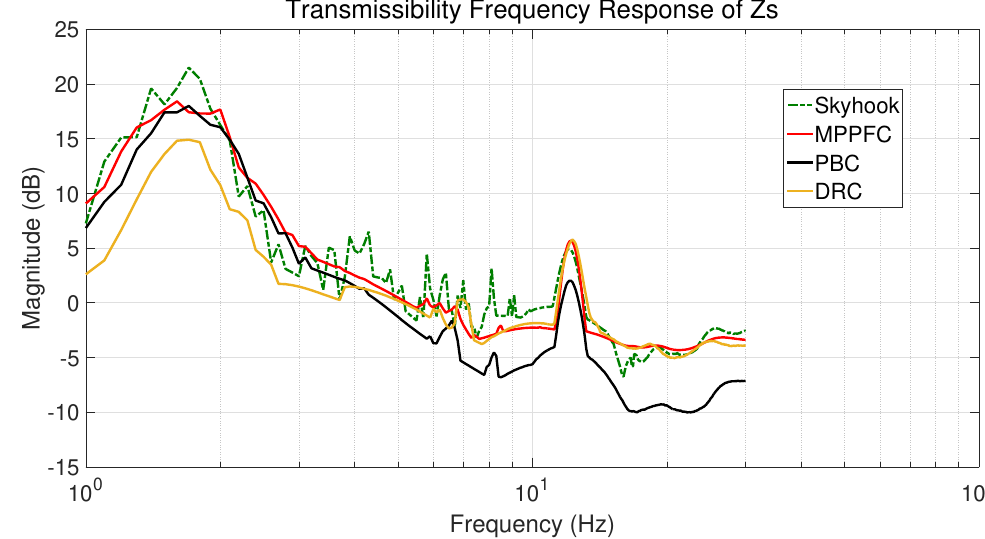
Figure 10. Comparison of TFR of the sprung mass displacement for different damping control and variable sprung